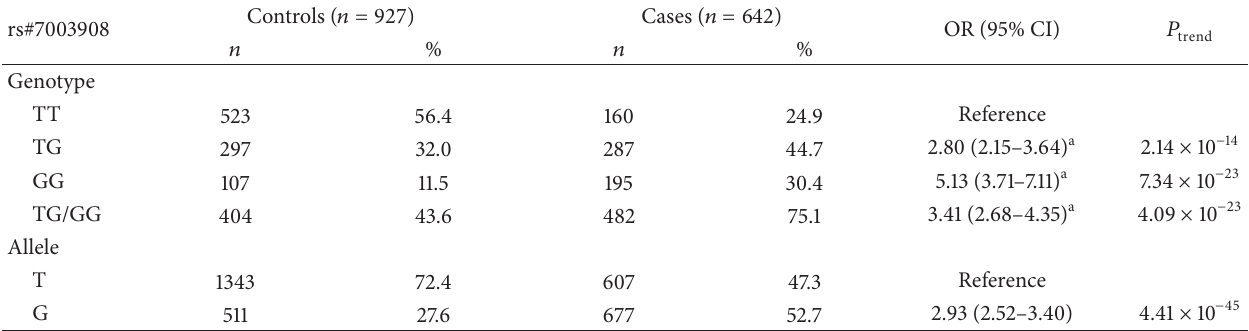
Table 3: XRCC7 rs#7003908 polymorphism and GAA